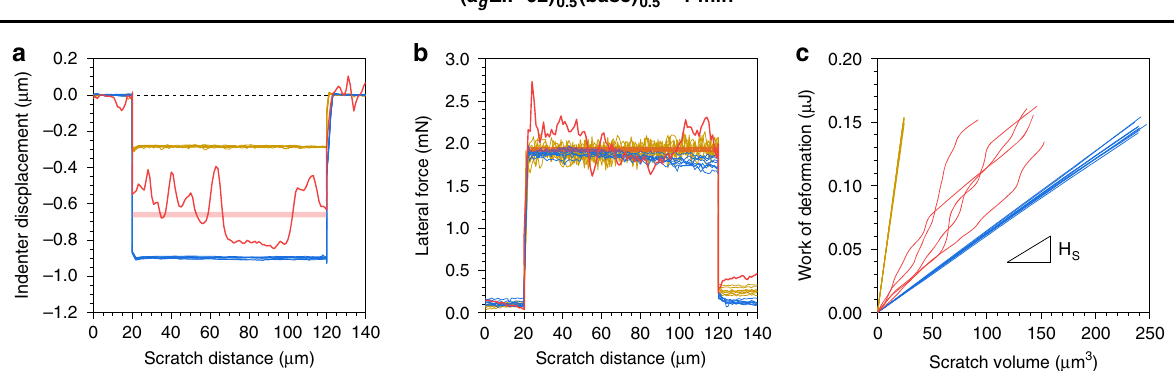
Fig. 5 Scratch resistance. a Spatial variation in indenter displacement ( h ). b Spatial variation in lateral force ( F L ) as monitored during a constant-load scratch test across the surface of the samples. c Work of deformation ( W S ), as derived from the integral of F L across 80 µ m, neglecting the fi rst and last 10 H fi ned as the slope of µ m of each scratch, versus the corresponding scratch volume ( V S ) of the investigated glass samples. The scratch hardness ( S ) is de the linear regression curve of W S versus V S . Key: (a g ZIF-62) 0.5 (base) 0.5 – 1 min — red, base — gold and a g ZIF-62 — blue. Red shades display the con fi dence intervals (95 %) for a) h and b) F L as derived from multiple such scratch tests performed on the (a g ZIF-62) 0.5 (base) 0.5 – 1 min